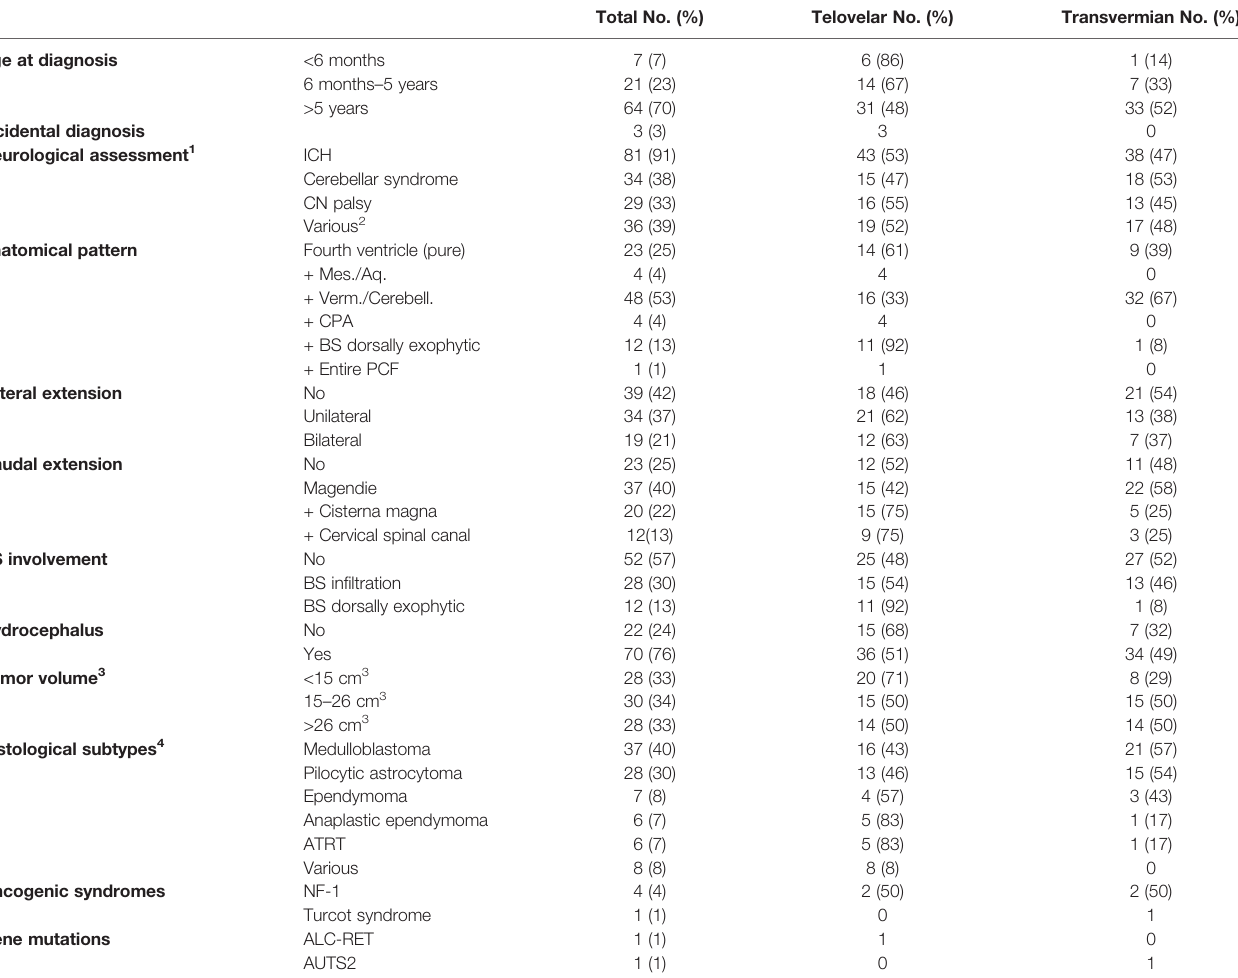
TABLE 1 | Preoperative clinical, radiological, and pathological assessment.